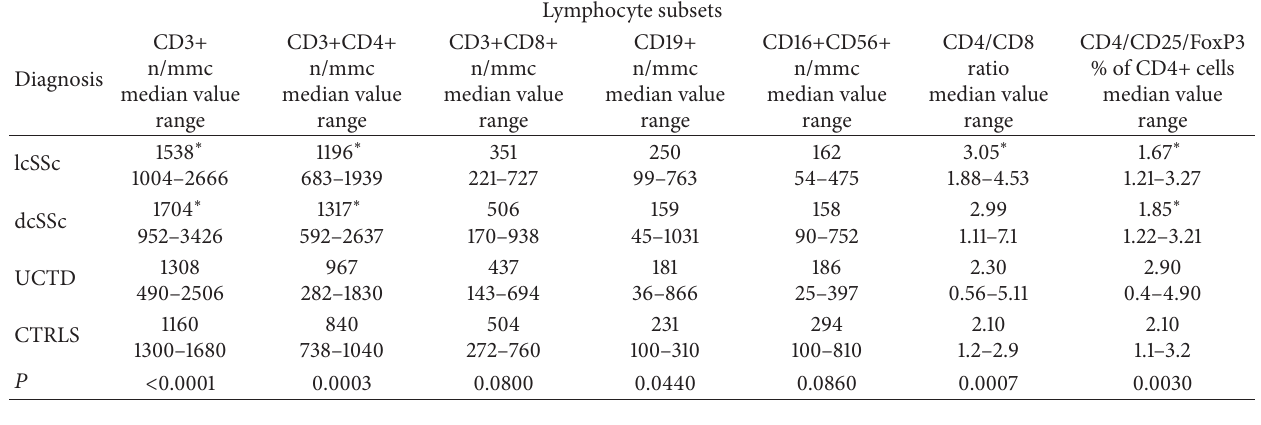
Table 4: Peripheral lymphocyte subsets including T reg cells in patients and controls.